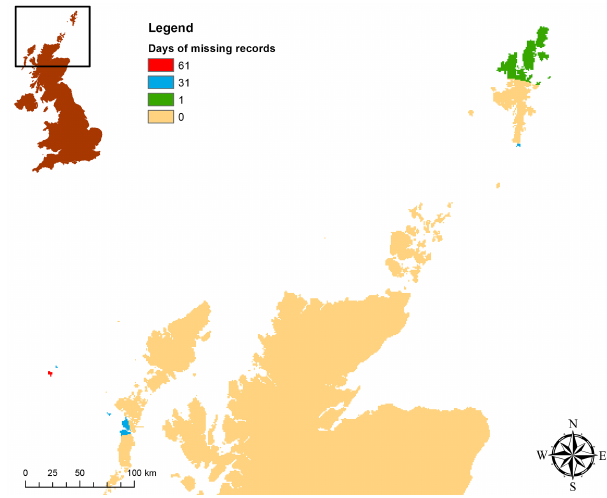
Figure 7. Map of total days of missing records (for daily grids) for the period post-1961 for northern Scotland (no missing records in rest of